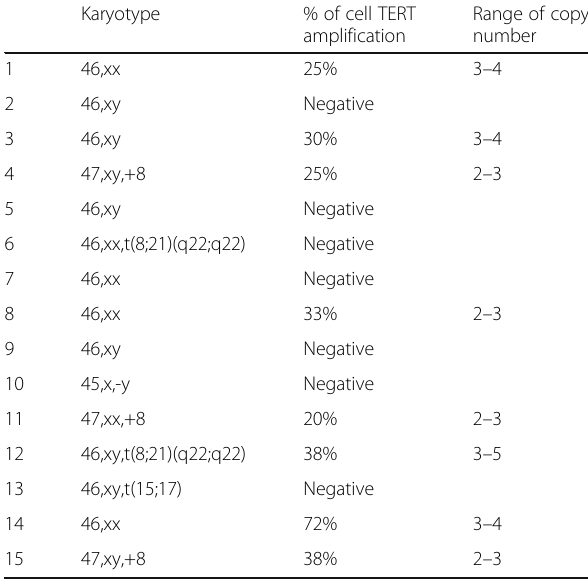
Table 6 Cytogenetics results of acute myeloid leukemia (group